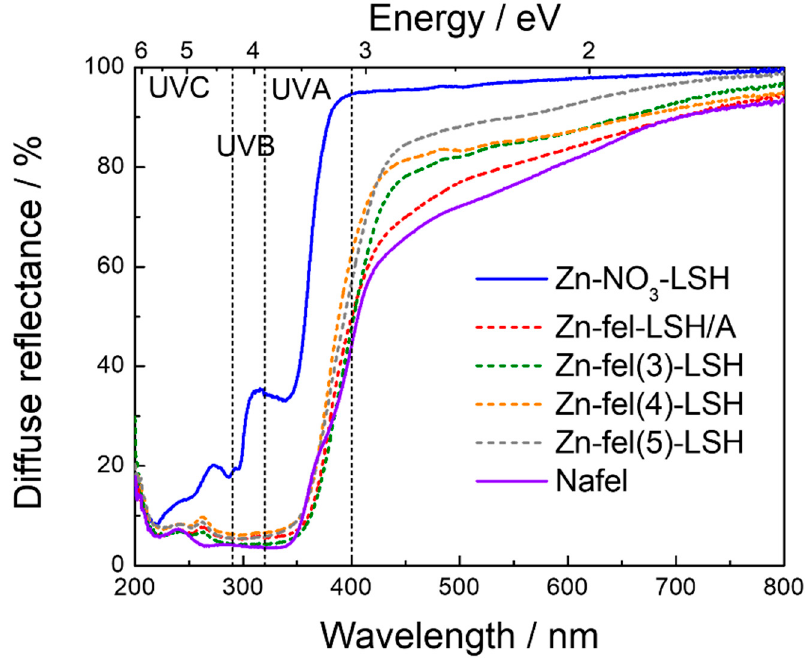
Figure A2. Diffuse reflectance spectra of Zn-NO 3 -LSH, Zn-fel-LSH/A, Zn-fel(3)-LSH,